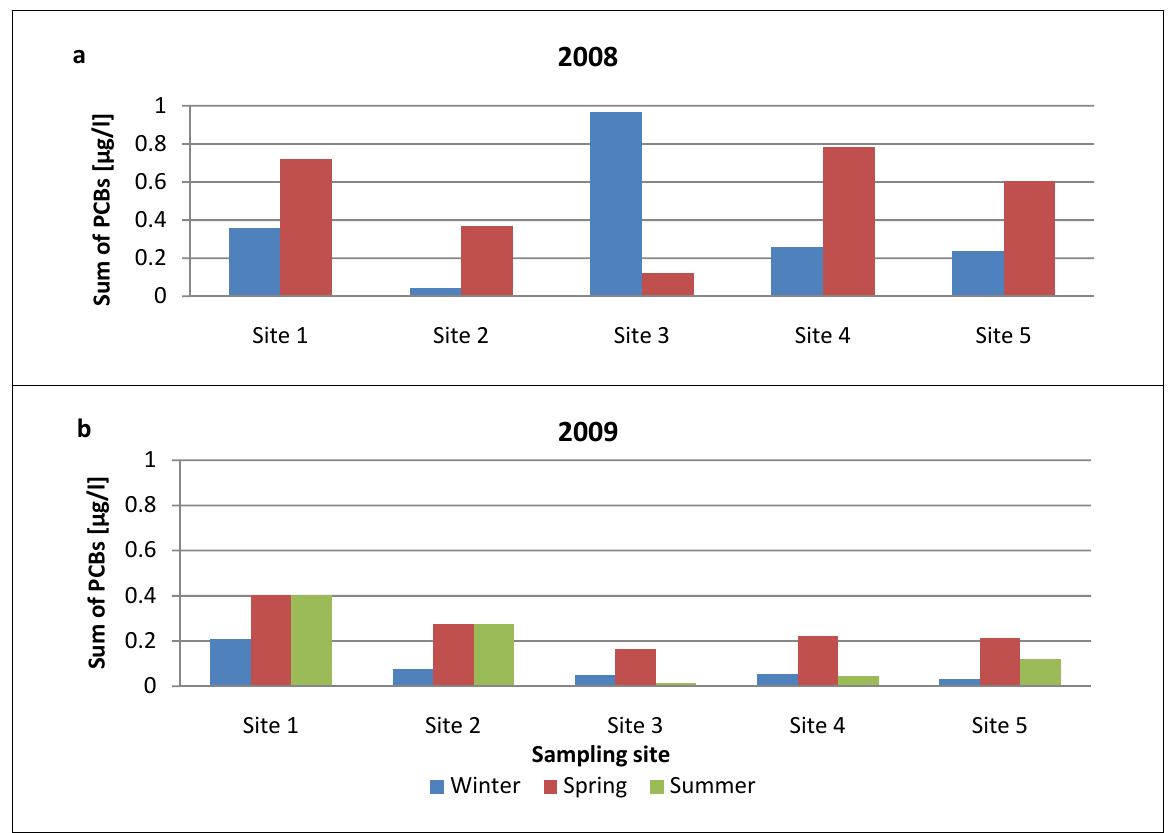
Figure 7. Seasonal changes in overall PCB levels in samples of airport runoff water in